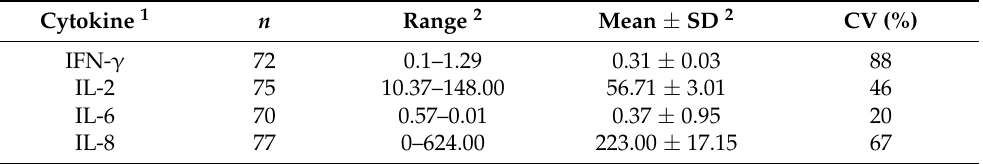
Table 3. Ranges of different cytokines analyzed. The table shows the number of data analyzed ( n ), range, mean ± standard deviation (SD), and coefficient of variation (CV).